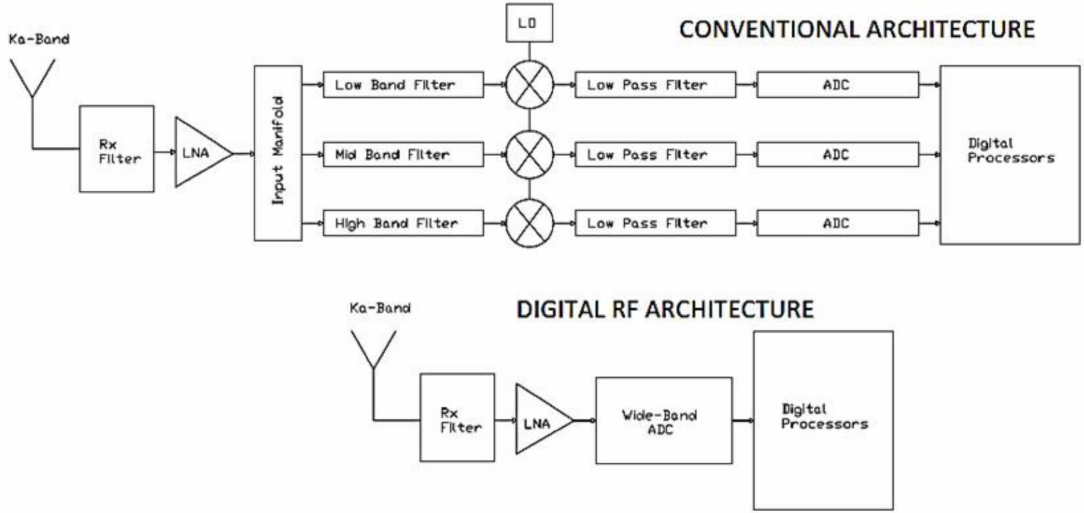
Figure 5. Comparison of conventional and digital RF